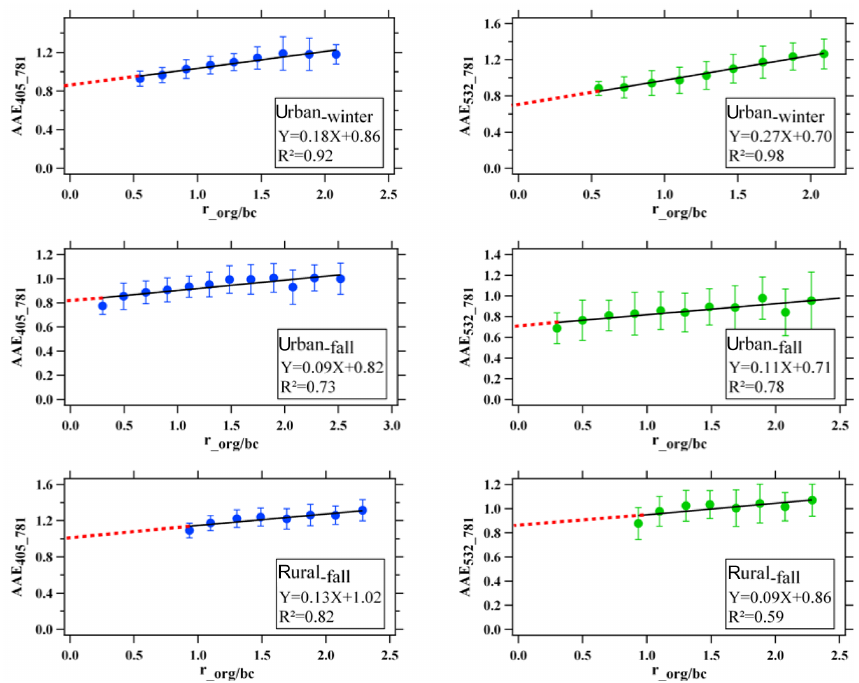
Figure 2. The linear relationship between AAE and r org/bc in the different campaigns.